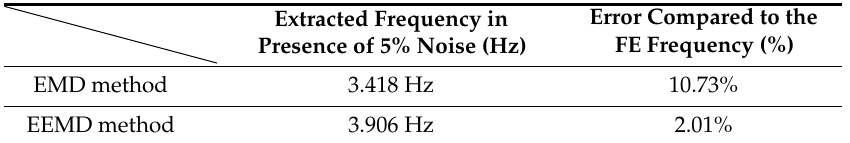
Figure 10. ( a ) IMFs of the vehicle acceleration response and ( b ) FFT spectra of the vehicle acceleration response in presence. Table1. Comparisonof thefirst frequency estimatedby EMDandEEMD inthe presence ofmeasurement noise (FE: finite